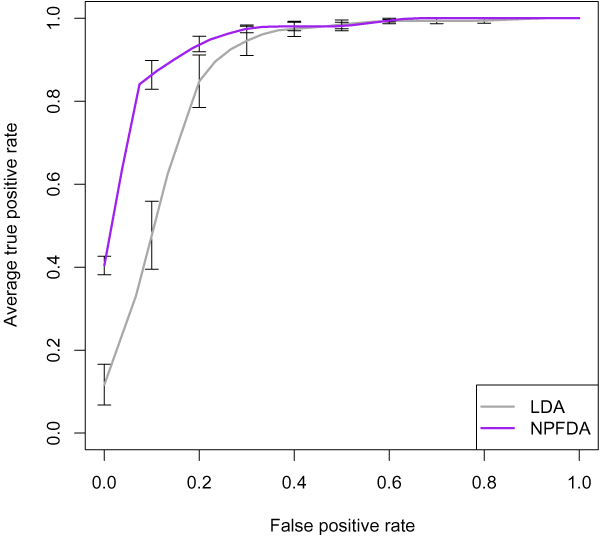
ROC curve for classification. The ROC curves plot the true positive (sensitivity) versus false positive (1-specificity) for NPFDA and LDA classification. Error bars show standard deviation over the CV replications.